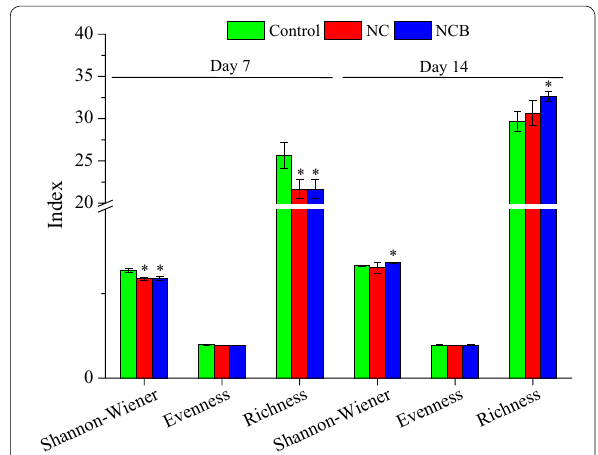
Fig. 3 Diversity index of bacterial community in soil with different treatments. Each column represents the mean of three replicates, and the error bars represent the standard deviations. Asterisk (*) indicates statistical significance of treatments in comparison to the control at p < 0.05